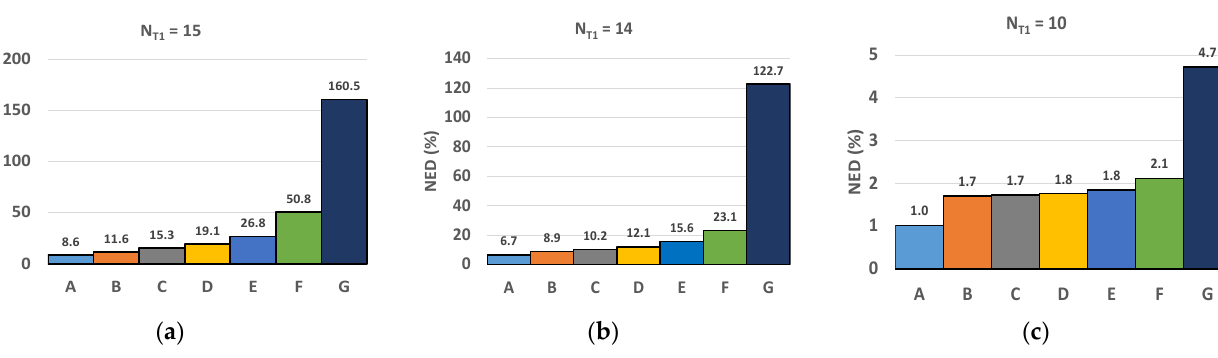
Figure 6. MRED (mean relative error distance) of CF dyn and CF static for a 7 × 7 convolution applied on the airplane benchmark: ( a ) N T 1 = 15, ( b ) N T 1 = 14, ( c ) N T 1 = 10 . F = 4. A: Proposed approach with N T 2 = 0 and double computation on the same pixel to update CF dyn . B: Proposed approach with N T 2 = 0 and adopting simplifications (1) and (2). C: Same as B, with N T 2 = N T 1 − 2. D: Same as B, with N T 2 = N T 1 − 3. E: Same as B, with N T 2 = N T 1 − 4. F: Same as B, with N T 2 = N T 1 − 5. G: Conventional static correction with N T = N T 1 truncated columns.